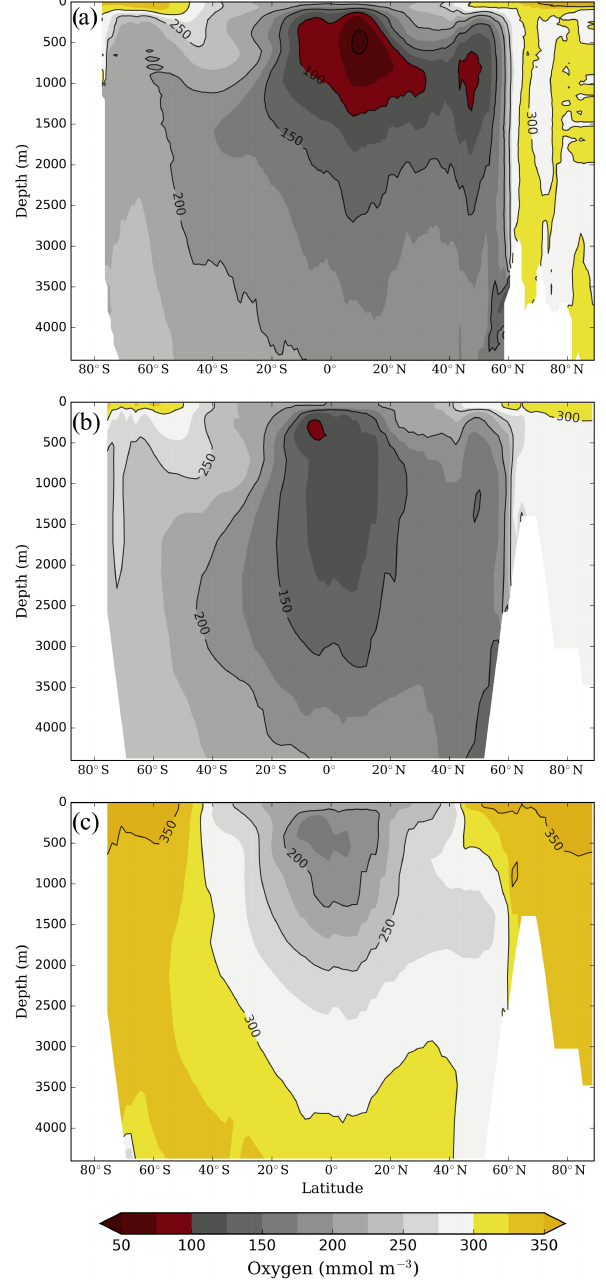
Figure 9. Zonally averaged dissolved oxygen concentrations (mmolm − 3 ) in (a) the modern ocean according to the World Ocean Atlas (Garcia et al., 2013), (b) the O-PI experiment and (c) the O- LGM